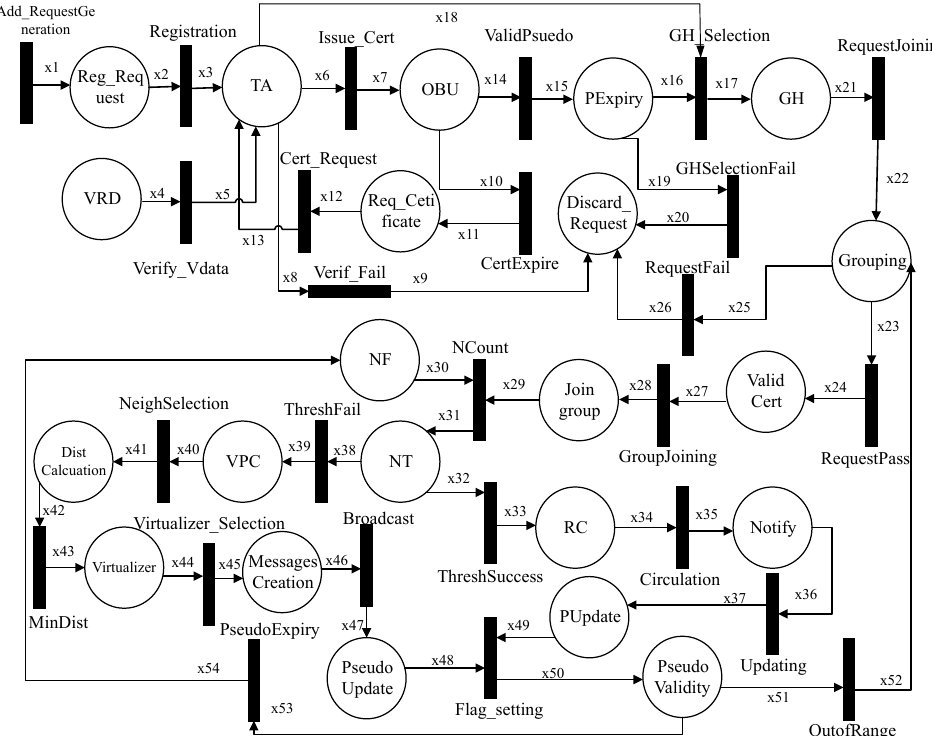
Figure 11. HLPN for DGVP